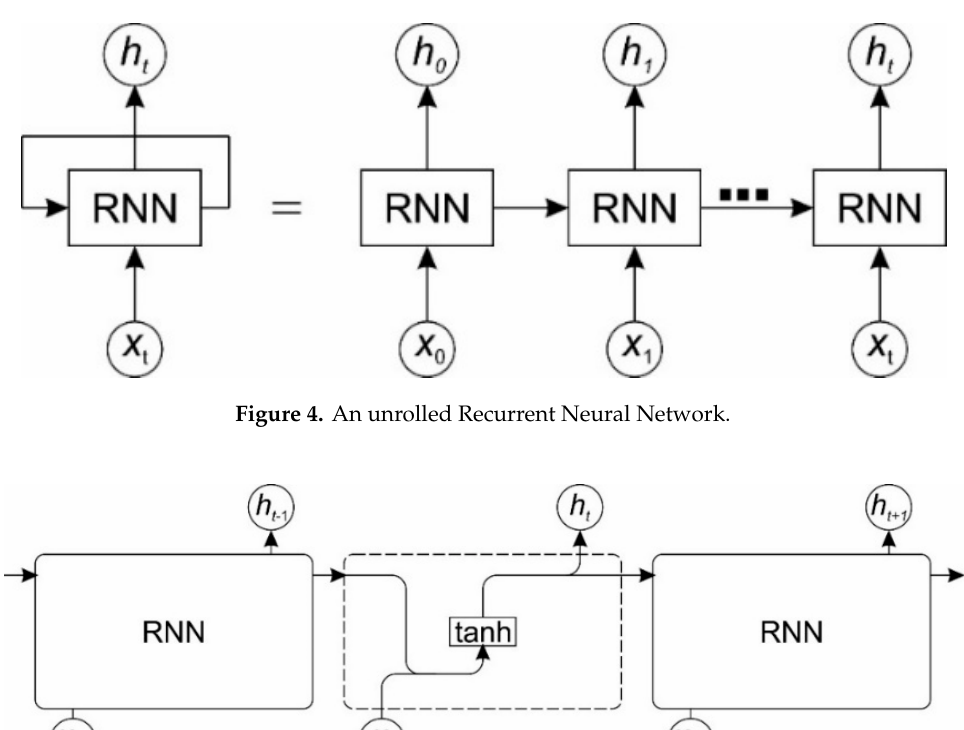
Figure 5. The repeating module in a standard RNN contains a single layer.